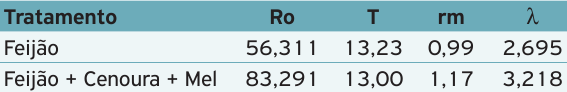
Tabela 3. Taxa líquida de reprodução (Ro), duração média